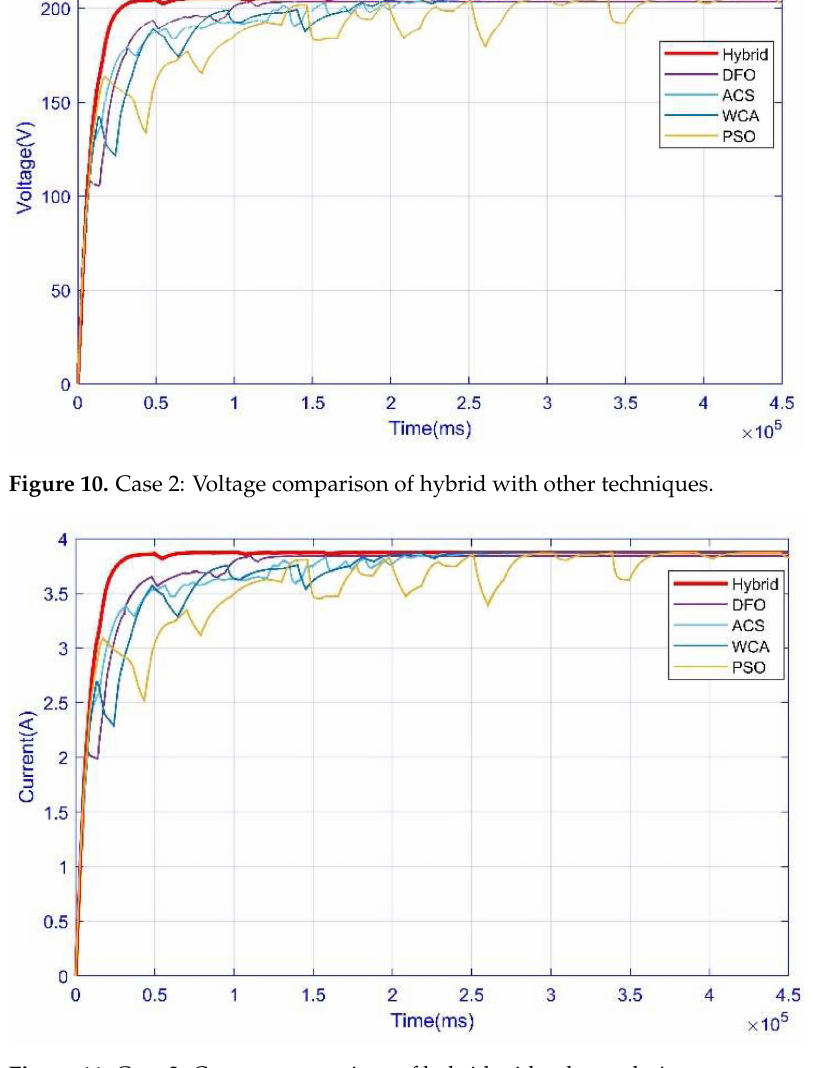
Figure 11. Case 2: Current comparison of hybrid with other